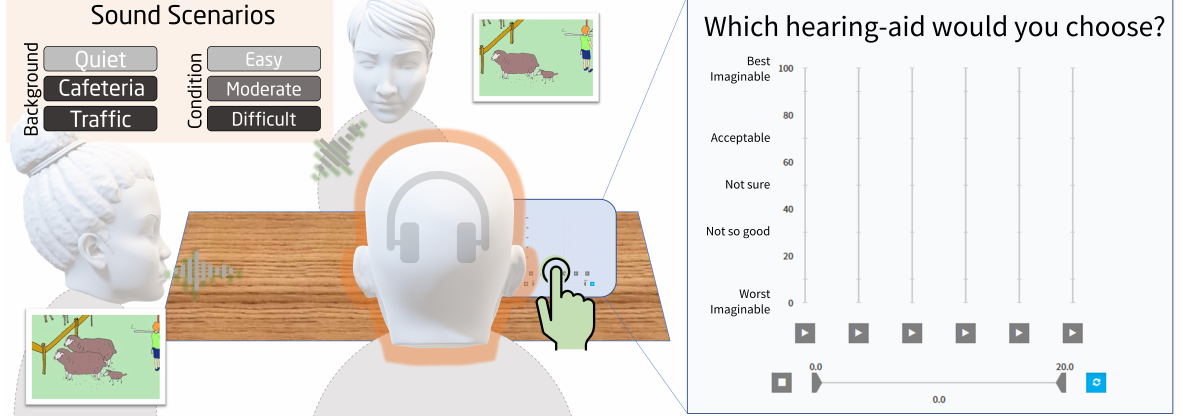
Figure 2. Illustration of the multi-comparison assessment. Left: sketch of the used sound scenarios. The listeners were engaged in a simulated scene consisting of a dialog between two talkers in a quiet or noisy environment. The conversation revolved around finding differences between two Diapix figures [14]. Three sound scenarios and three speech levels or SNRs were used. Right: graphical user interface of the SenseLabOnline software. The four candidate settings were tested in a multi-comparison paradigm that also included a hidden anchor and reference setting (HAS-O). The sound corresponding to a given setting was played back in a loop when the corresponding play button was pressed. The preference judgements were provided using the sliders. The listeners were instructed to (1) identify the anchor, (2) provide a first set of coarse preference ratings between “Acceptable” and “Not good”, (3) reorganize their ratings using the built-in ranking functionality in the SenseLabOnline software [15], and (4) listen to all stimuli again and refine their ratings before storing the final judgements. For each sound scenario, three repetitions per listener were